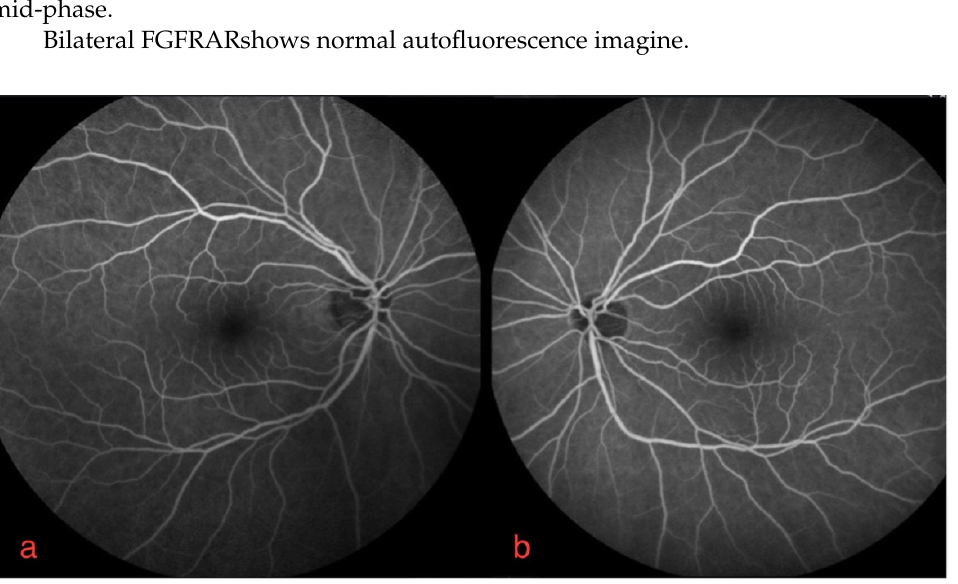
Figure 2. Fluorescein angiography of right ( a ) and left eye ( b ). Bilateral FGFRARshows no signs of staining or leakage in fluorescein angiography mid-phase.